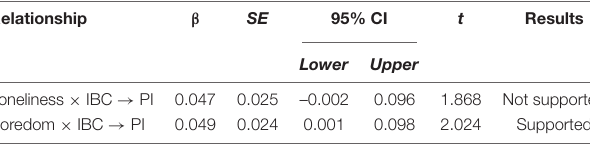
TABLE 4 | Moderation